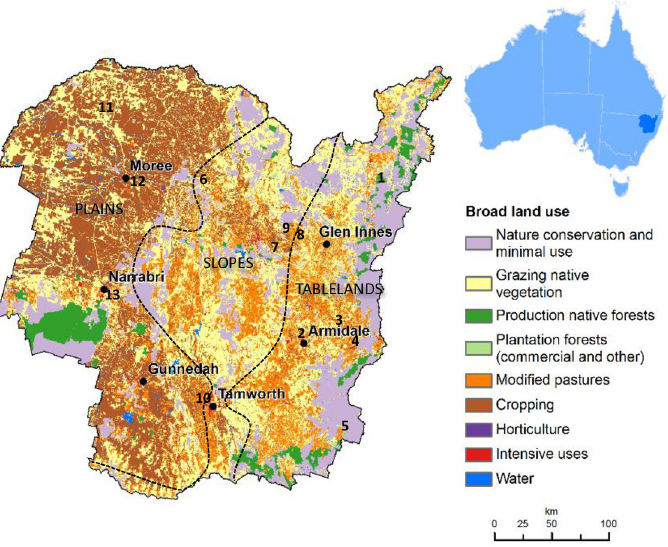
Fig 1. Map on the land use practices in the New England region of NSW, Australia [33] with the approximate boundaries of the tablelands, slopes and plains areas and location of the sampling sites (numbered) superimposed. Reprinted from [Catchment Scale Land Use of Australia] under a CC BY license, with permission from [Australian Bureau of Agricultural and Resource Economics and Sciences, ABARES], original copyright [2019].